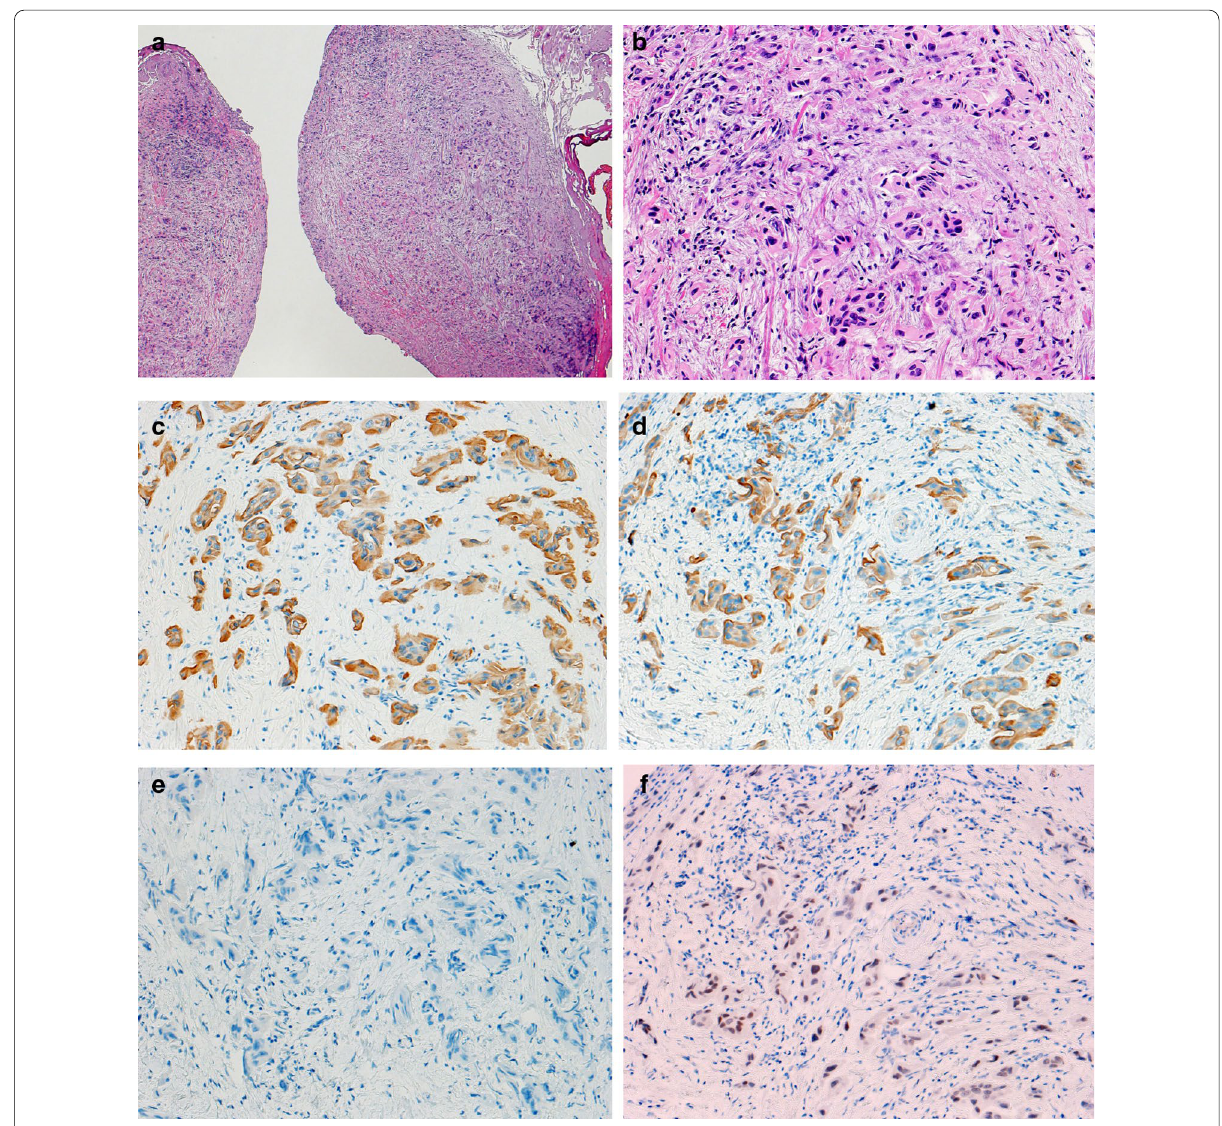
Fig. 2 Microscopic examination of the resected specimen revealed a conglomerate of hyperchromatic and scattered multiangular nuclei.. a H&E 40. b H&E 200. Immunohistochemistry showed that the tumor was positive for c CK7 ( × × staining for CDX2 revealed little reactivity